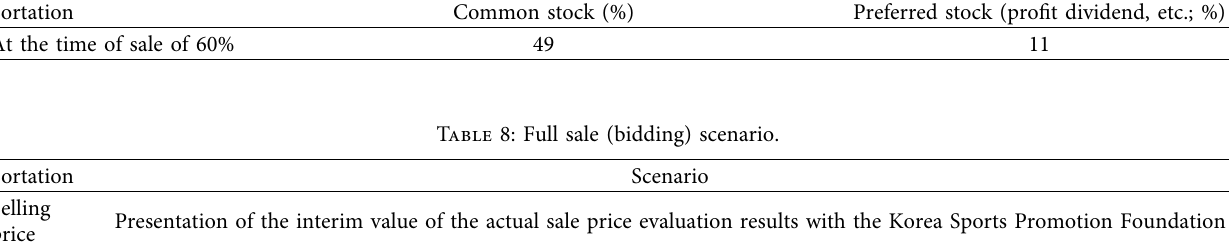
Table 7: Structure of the sale of shares exceeding 50% (proposal; unit: KRW 100 million).